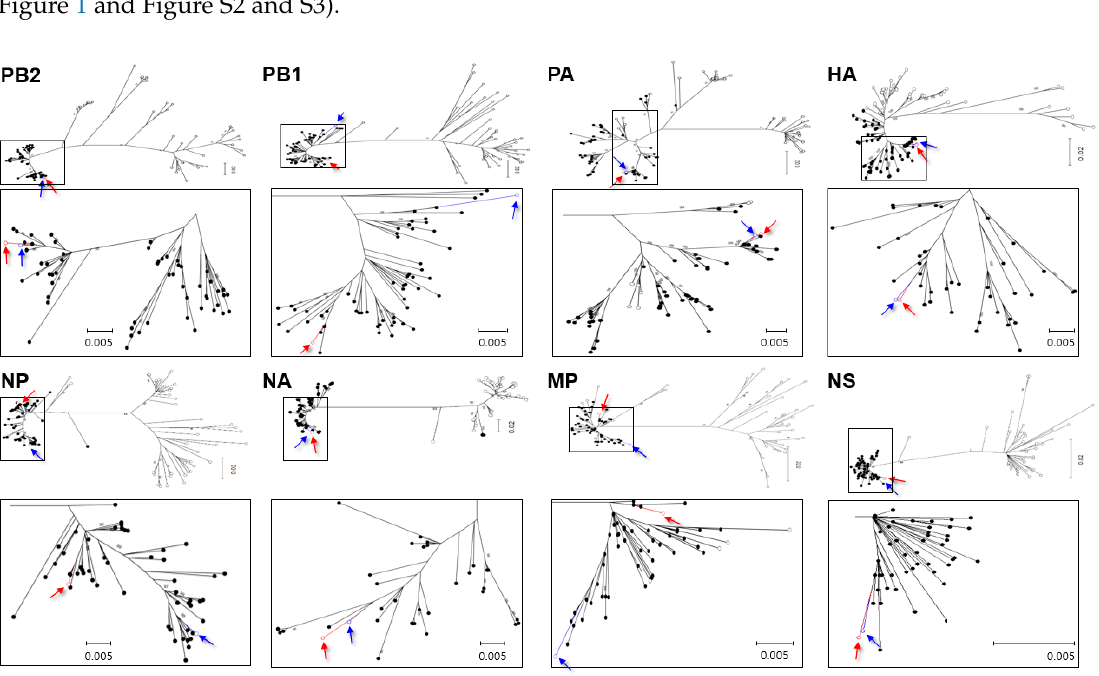
Figure 1. Maximum likelihood phylogenetic trees showing inferred relationships among nucleotide sequences for the complete coding regions of K6 and K17 gene segments. Red open circle indicates K6-H6N5 and blue open circle indicates K17. These are highlighted with red and blue arrows used for K6 and K17, respectively. Closed and open circles indicate lineages of North America and Eurasia, respectively.